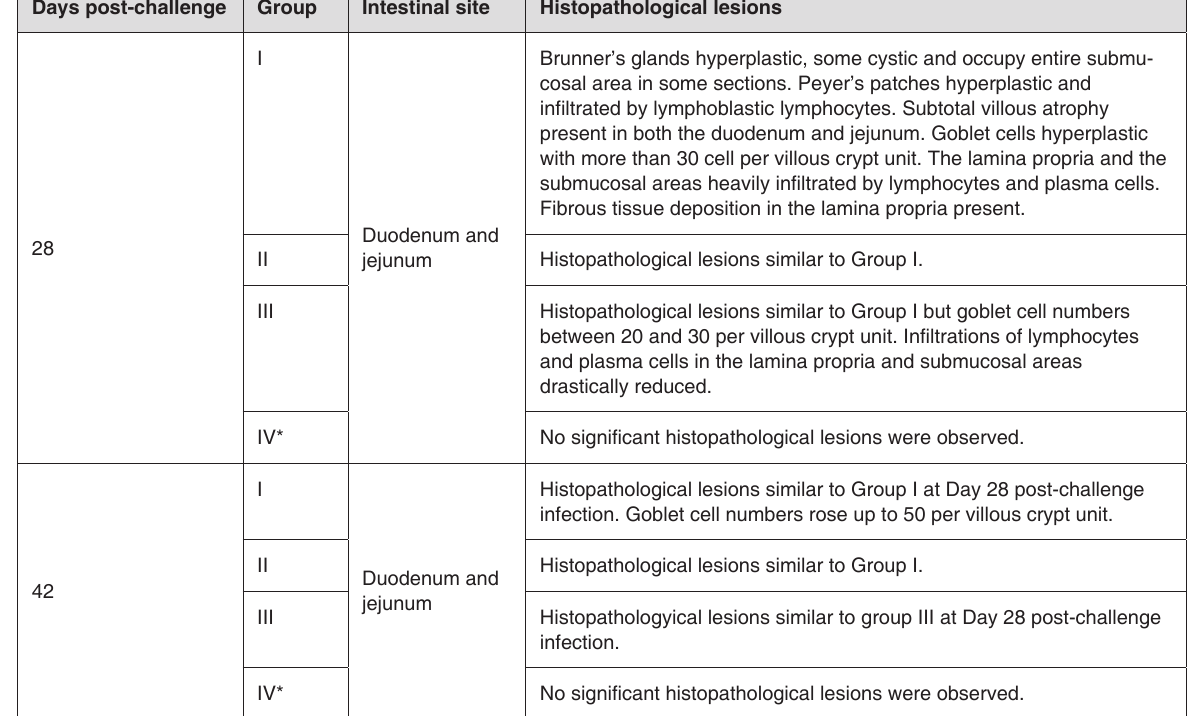
TABLE 4 Histopathological lesions of the duodenum and jejunum from the different groups of cattle immunized and challenged with Calicophoron microbothrium Days